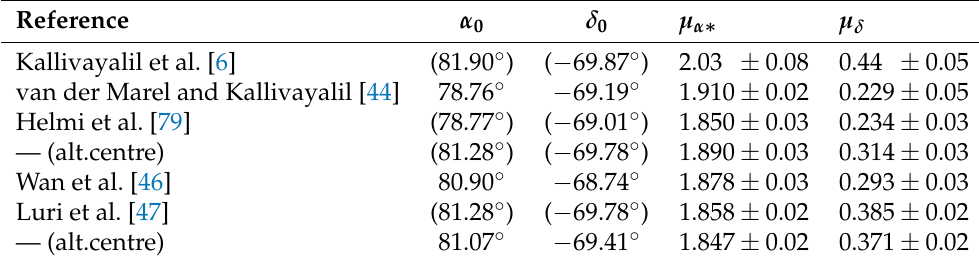
Table 2. Compilation of measurements of the LMC PM. α 0 and δ 0 are the ICRS coordinates of the measured centre point (or adopted from another study, shown in brackets); µ α µ δ d δ /d t are the corresponding PM components in masyr − 1 . See also Table 2 in D’Onghia and ≡ Fox [67] for a summary of older